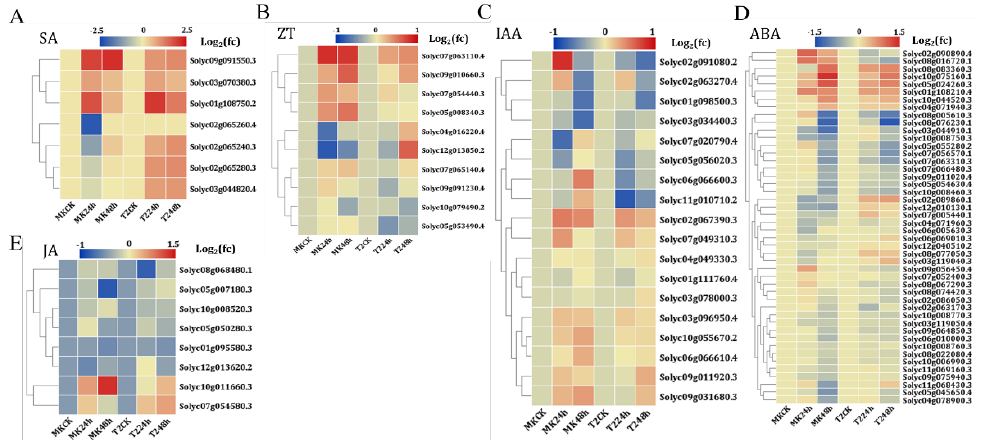
Figure 5. Plant hormone-related genes were differently expressed in TYLCV